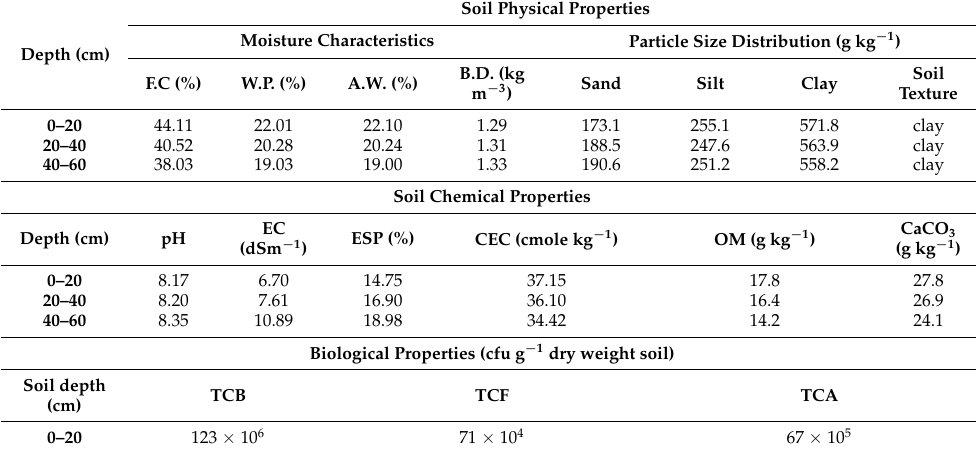
Table 2. Average values of some physicochemical and biological properties of the experimental site during the two cropping